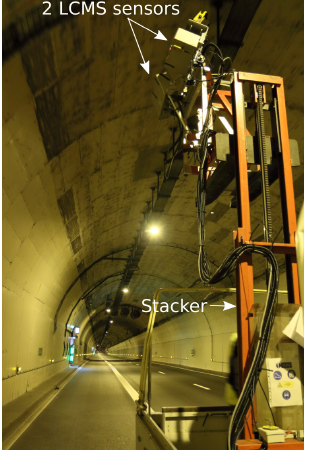
Figure 4. MALT Mobile prototype deployed in a tunnel.